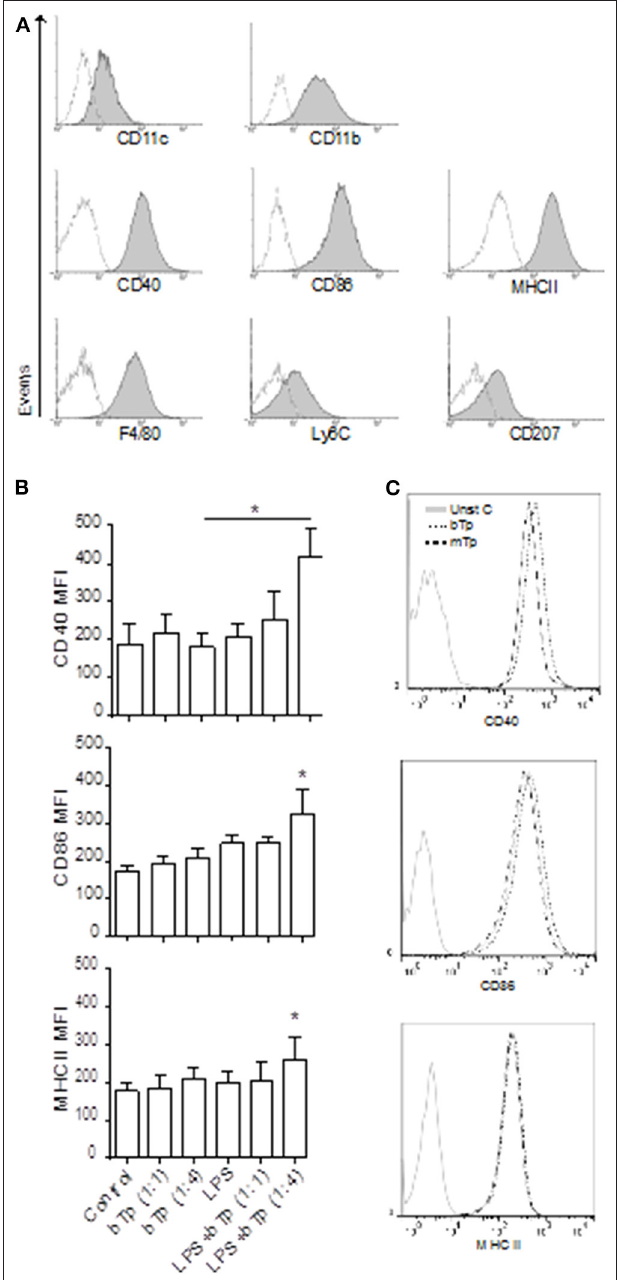
FIGURE 1 | Surface markers in XS106 cell line and comparative expression of activation markers in XS106 stimulated with bTp ± LPS or mTp. (A) XS106 were cultured at 1 × 10 6 /well, stained with anti-mouse CD11c, CD11b, CD40, CD86, MHCII, F4/80, Ly6C, CD207 monoclonal Abs and analyzed by flow cytometry. One independent experiment of five is represented by histograms. Dotted line represents negative control for the staining. (B,C) 5 × 10 5 cells XS106 were incubated for 24h with medium (control), bTp with or without LPS (B) , and bTp vs. mTp (C) . CD40, CD86, and MHCII were analyzed by flow cytometry. Bar graphic represents MFI (mean fluorescence intensity), mean ± SEM ( n = 5), * p < 0. 05. One-way ANOVA and Bonferroni’s post-hoc correction.